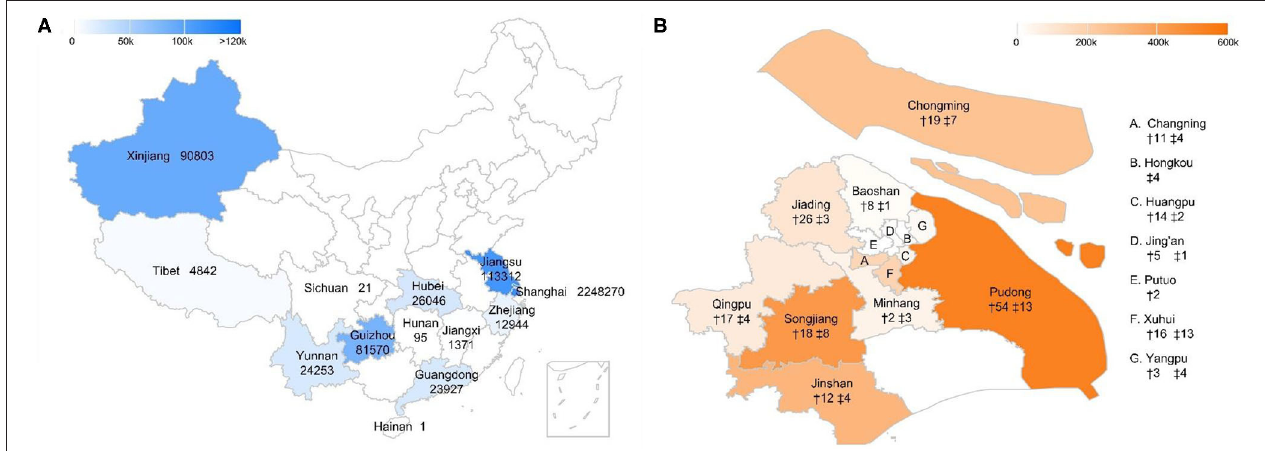
FIGURE 1 | Medical institutions covered by the ECG platform in China and Shanghai. (A) Regions covered by the remote ECG platform in China. The number following the province name shows the number of medical visits with ECG examinations in that province between Jan 1, 2018 and Apr 7, 2021. (B) Number of medical institutions covered by the ECG platform in Shanghai. † and ‡ indicate the number of community clinics and academic hospitals in that district.